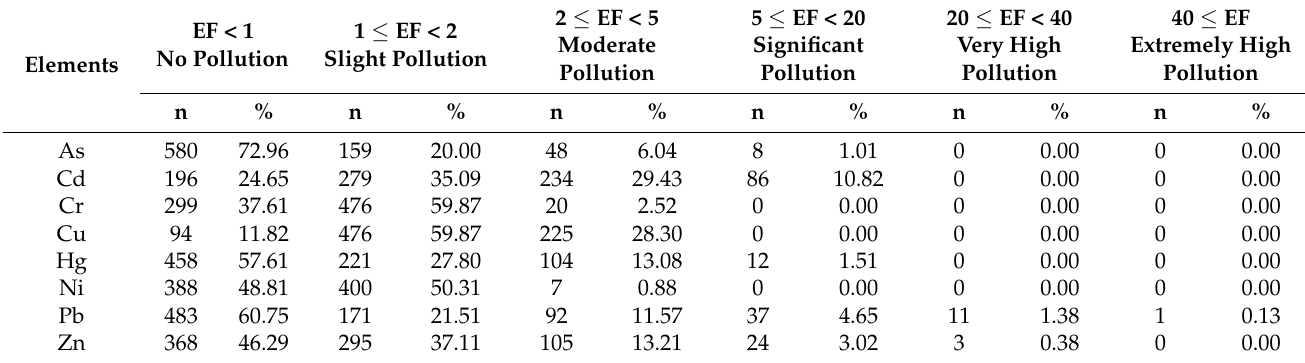
Table 2. Environmental risk levels of heavy metals in study